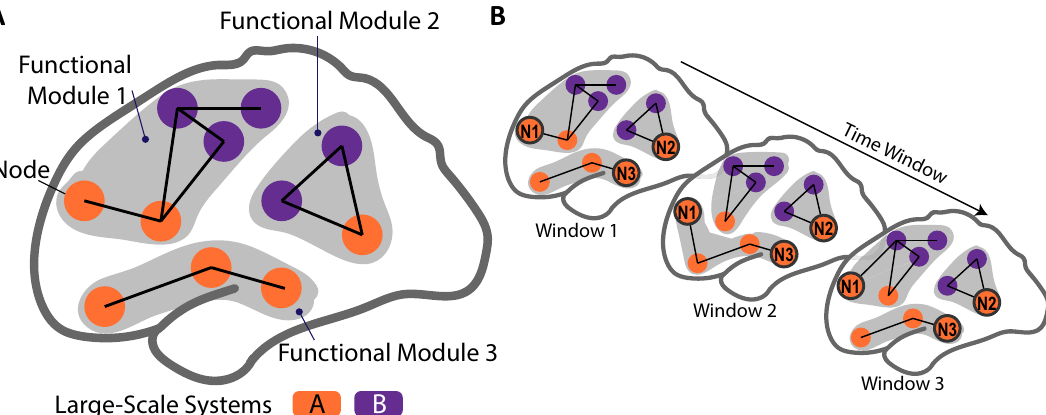
Figure 1. Schematic of functional modules and large-scale systems. ( A ) Each orange or purple circle represents a node (brain region). All orange nodes are part of large-scale system A and all purple nodes large-scale system B. Based on the functional connections and modularity, these nodes form three functional modules (shaded gray regions). ( B ) In a dynamic modular network, modules and connections may differ over time windows, as a result of adapting to different task demands. Node N1 switches which functional module it belongs to at each time window. This means node N1 has high flexibility . Node N2, part of large-scale system A (orange), is more connected to nodes in large-scale system B (purple) throughout the three time windows. This means node N2 has high interaction with nodes in a different large-scale system (high integration ). In contrast, node N3 is more connected to nodes in large-scale system A. This means node N3 has high interaction with nodes in its own large-scale system (high recruitment